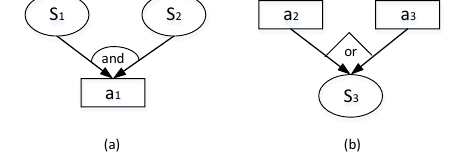
Fig. 1 Basic dependence relation among nodes in the probabilistic attack